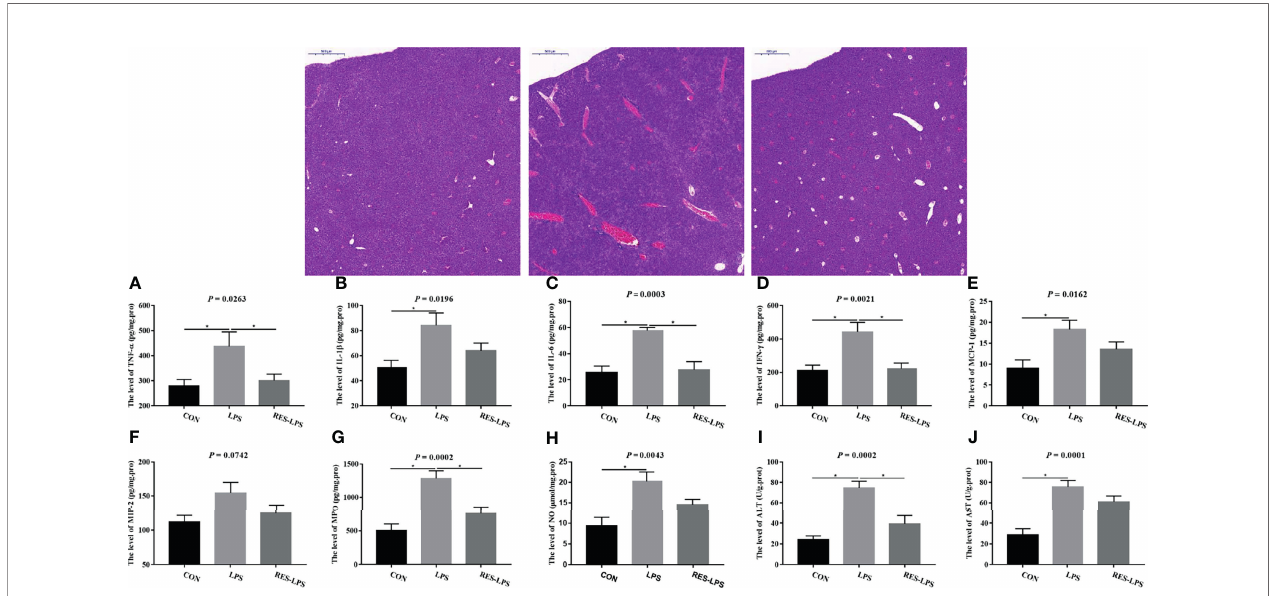
FIGURE 2 | Effects of RES on liver injury and in fl ammation induced by LPS. (A – J) Levels of TNF- a , IL-1 b , IL-6, IFN- g , MCP-1, MCP-2, MPO, NO, ALT, and AST in the three groups. Liver histopathology images of tissue samples of the CON, LPS, and RES – LPS groups (hematoxylin and eosin staining; ×100). *p <